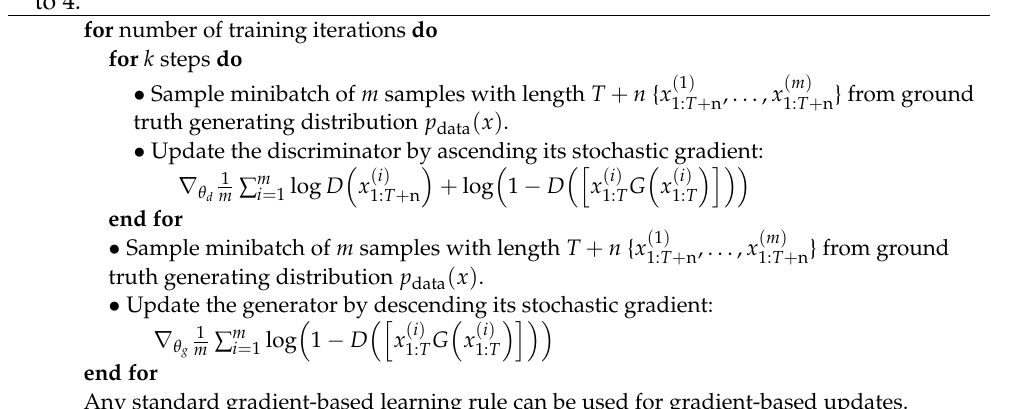
Algorithm 1: Minibatch stochastic gradient descent training of